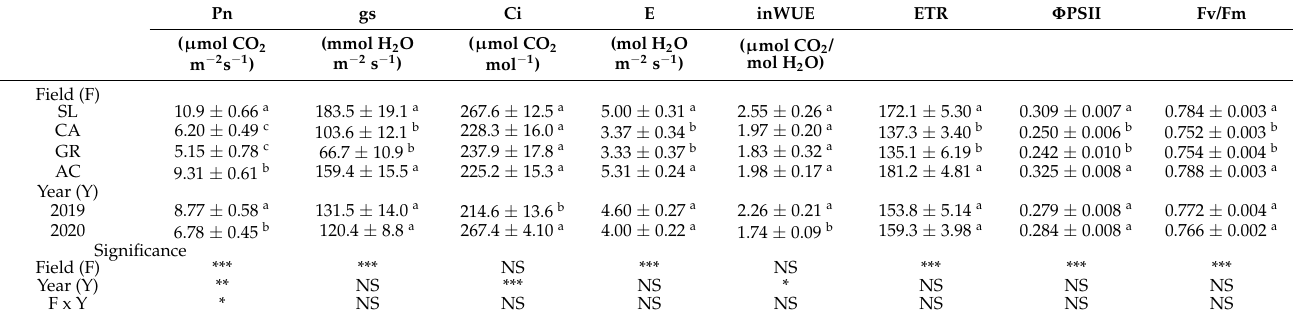
Figure 1. Combined effect of field and year (F x Y) on bunch weight ( a ) and bunch number ( b ) of V. vinifera subsp. vinifera ‘Falanghina’ vines at the four study sites: SL-Santa Lucia, CA-Calvese, GR-Grottole, AC-Acquafredde. Mean values and standard errors are shown. Different letters indicate significant differences according to Duncan’s multiple range test ( p ≤ 0.05). Table 2. Effects of field (F), year (Y) and their interaction (F x Y) on net photosynthetic rate (Pn), stom- atal conductance (gs), substomatal CO 2 concentration (Ci), leaf transpiration rate (E), instantaneous water use efficiency ( in WUE), electron transport rate (ETR), quantum yield of PSII linear electron transport ( Φ PSII), and maximum quantum efficiency of PSII photochemistry (Fv/Fm) of V. vinifera subsp. vinifera ‘Falanghina’ vines at the four study sites: SL-Santa Lucia, CA-Calvese, GR-Grottole, AC-Acquafredde. Mean values and standard errors are